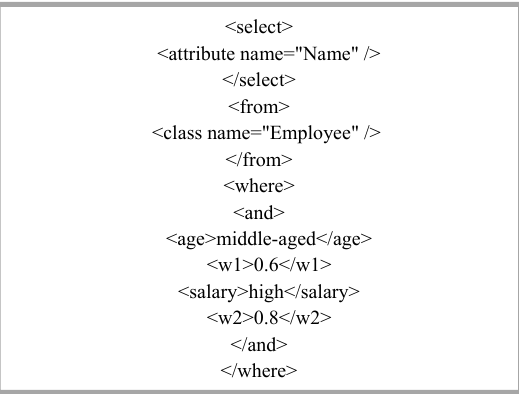
Fig. 11. Execute second